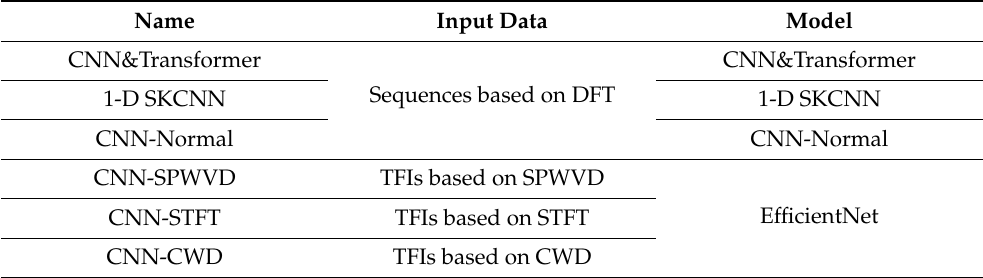
Table 4. The name of the methods in experiments with the according used input data and